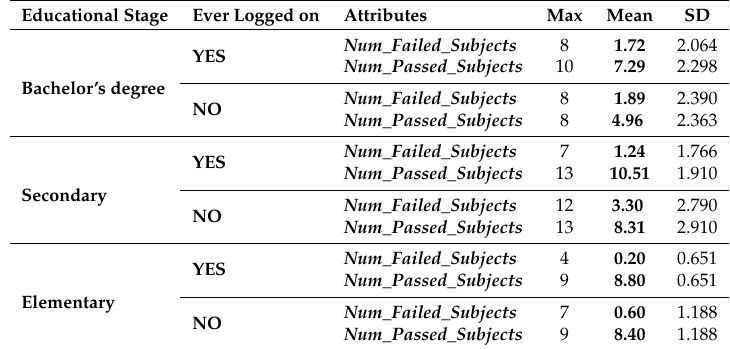
Table 4. Descriptive analysis of the number of subjects failed and passed by students divided by educational stages.